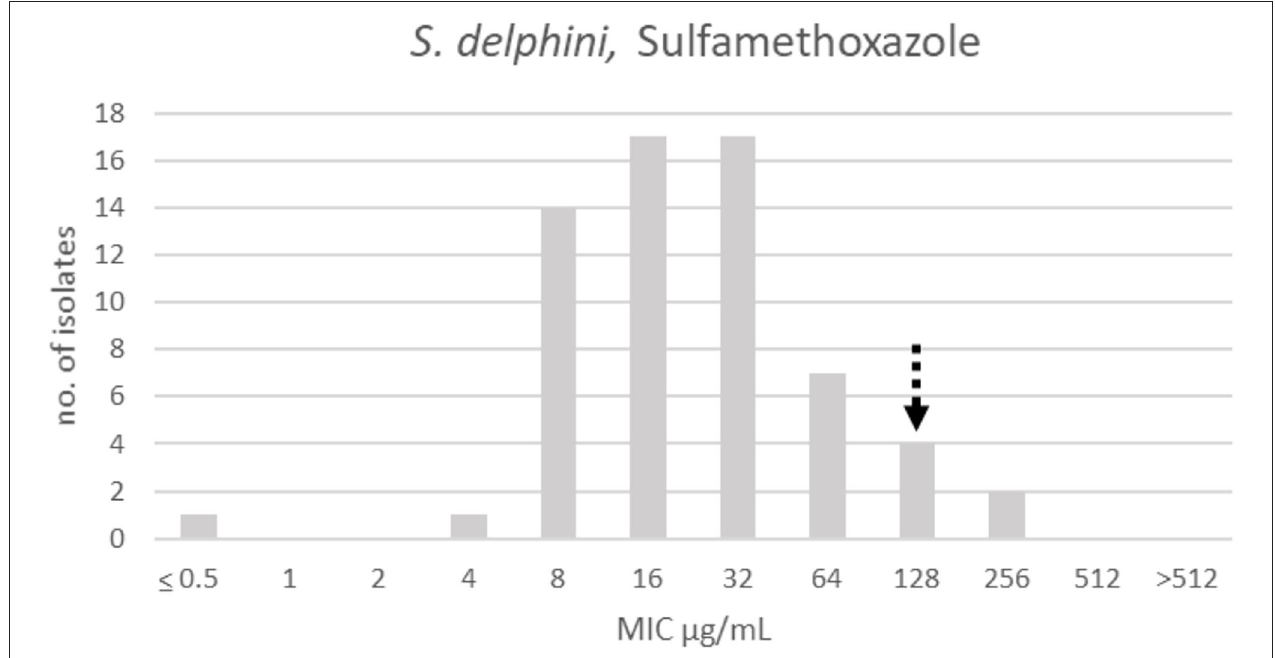
FIGURE 12 | MIC distribution of Staphylococcus delphini ( n = 63) against sulfamethoxazole in the test range of 0.5–512 µ g/mL. The broken arrow indicates the tentative epidemiological cut-off value (TECOFF).